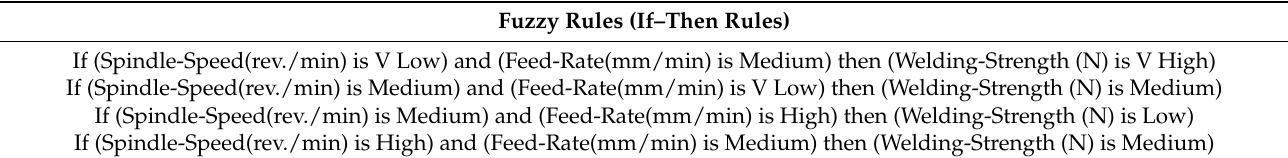
Table 13. If–Then rules of FSSW strength fuzzy systems.